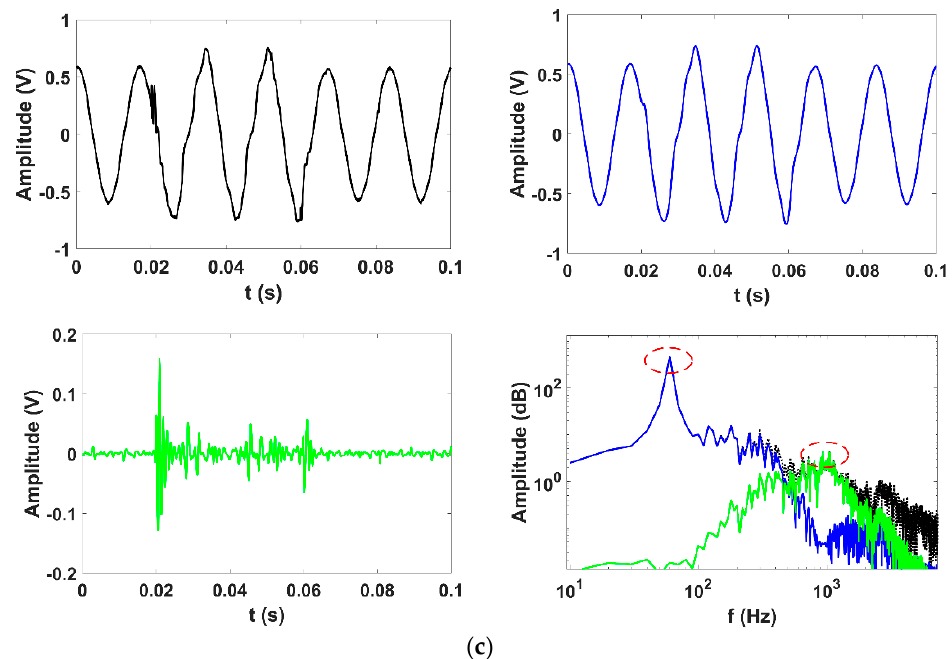
Figure 10. The decomposed results of four real-time signals by using VMD: ( a ) phase A, ( b ) phase B, and ( c ) phase C.